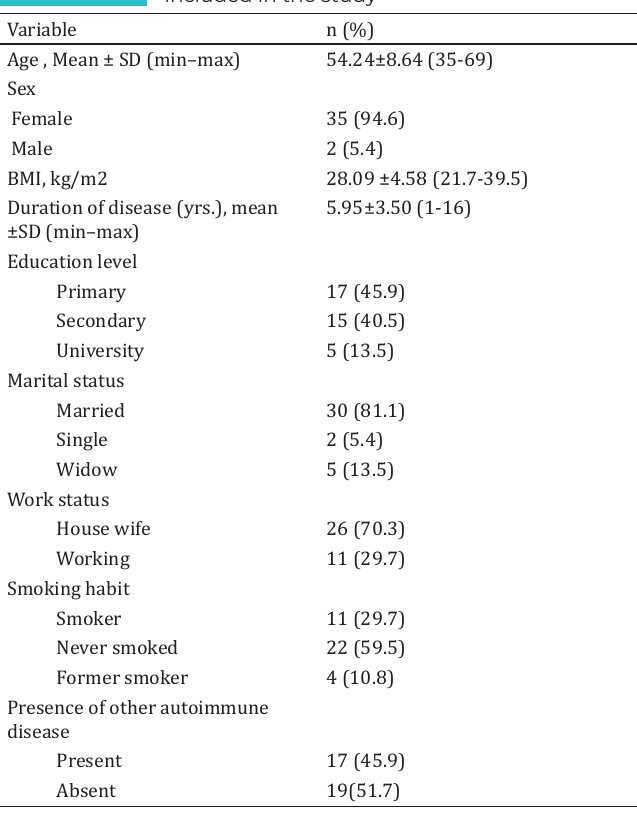
Demographic characteristics of the patients included in the study